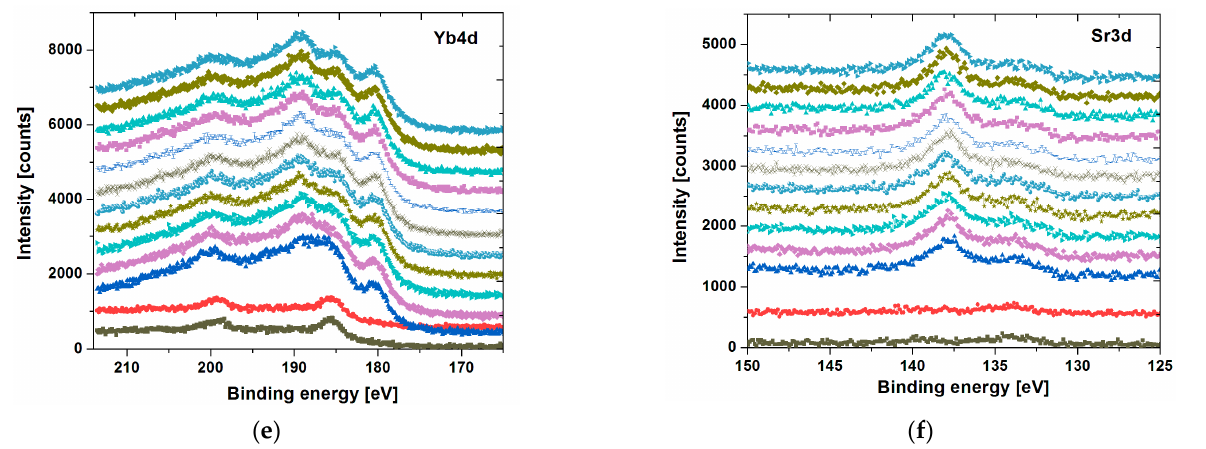
Figure 8 . XPS core level lines of O1s ( a ), Mg2p ( b ), Zn2p ( c ), Ca2s ( d ), Yb4d ( e ), and Sr3d ( f ) of Mg 60 Zn 20 Ca 2.6 Yb 15.7 Sr 1.7 plate after corrosion tests in Ringer’s solution at 37 °C.